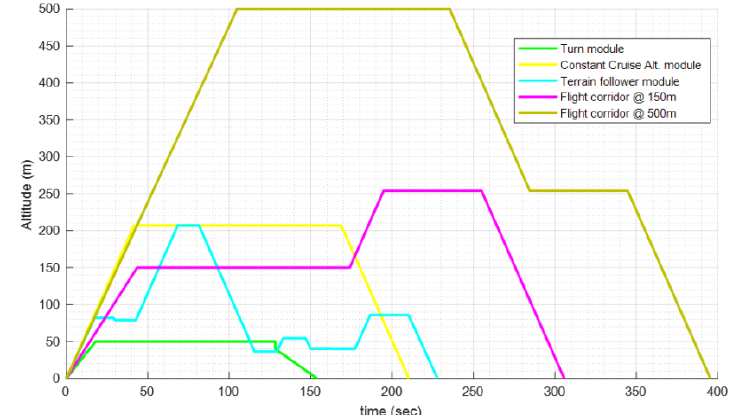
Figure 14. Flight altitude time histories for airspace volumization and flight corridor solutions for Figure 13 example.